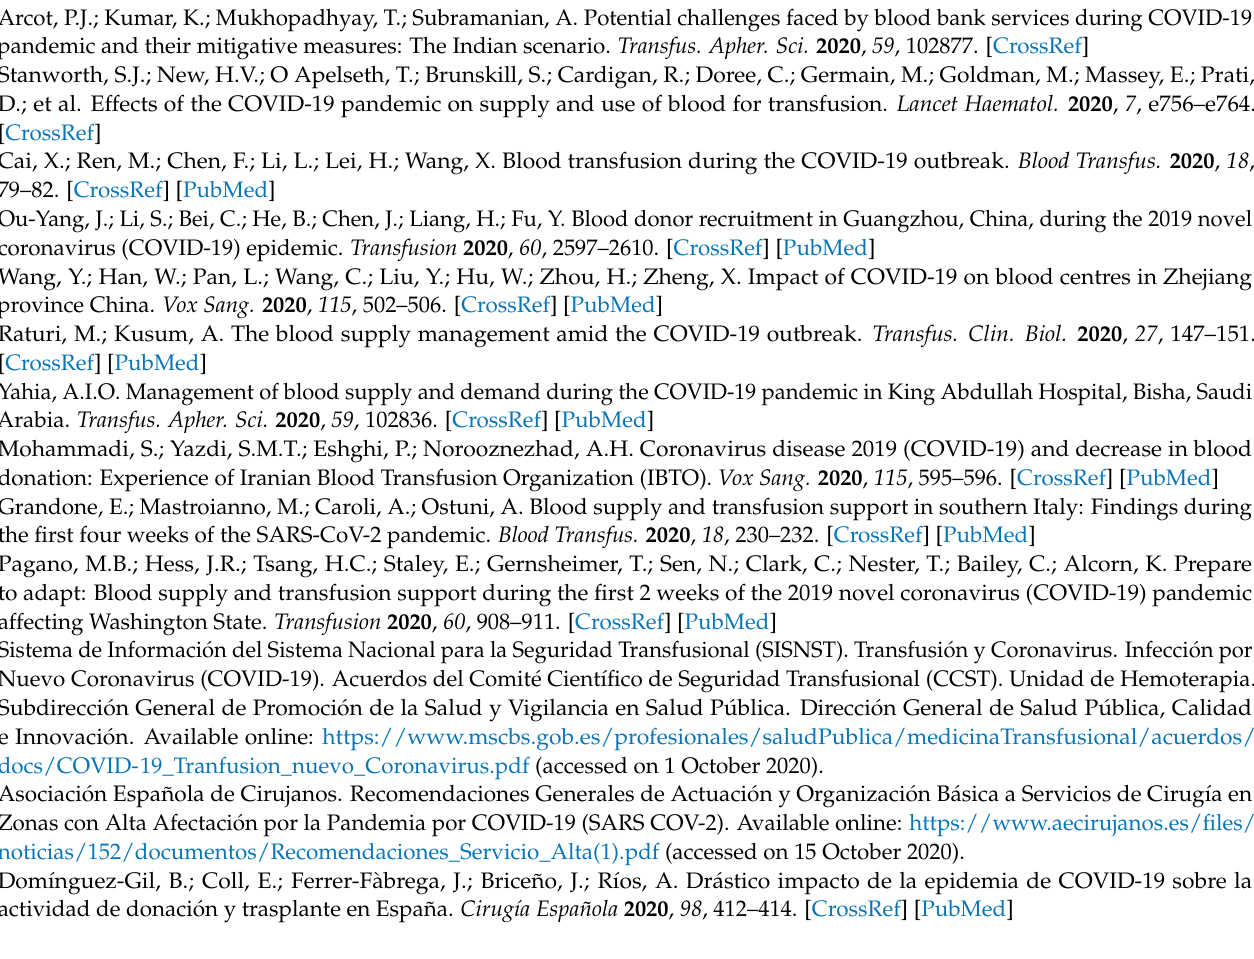
Figure A3. Fresh frozen plasma (excluding the Miguel Servet University Hospital due to an “outlier” for presenting a result of 235% increase in Period 0).